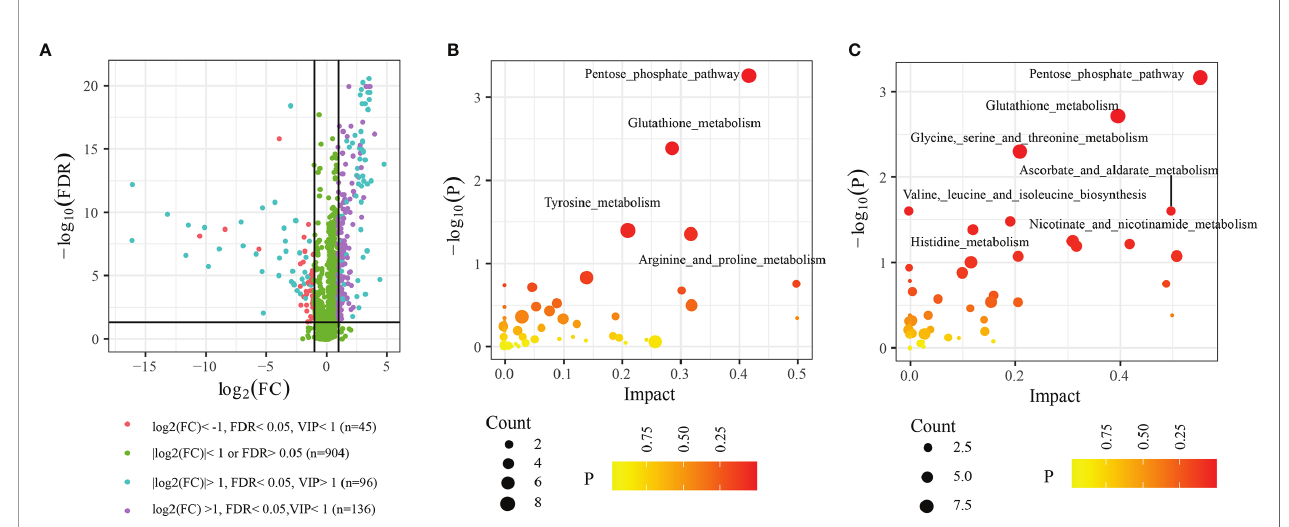
FIGURE 7 | Differential metabolites and functional enrichment analysis. (A) 96 differential metabolites between H and LUAD group. (B) The metabolic pathways are enriched by 96 differential metabolites. (C) The metabolic pathways enriched by metabolites are highly related to the three biomarkers ’ taxa. FDR, False discovery rate; VIP, Variable importance in projection; FC, Fold